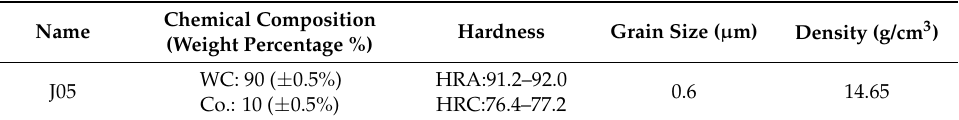
Table 2. Material properties of tungsten